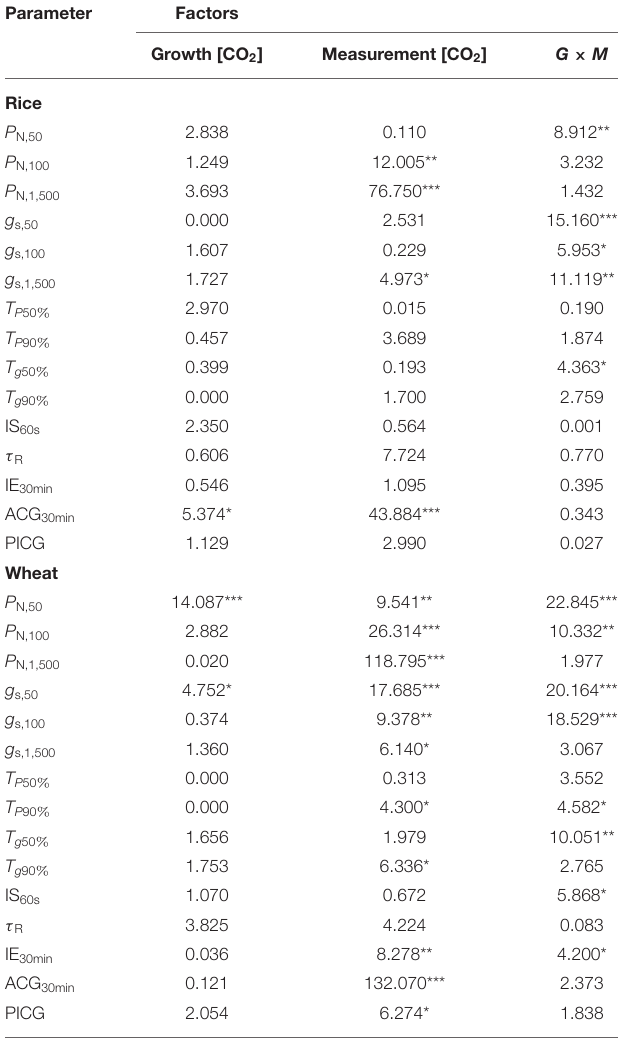
TABLE 3 | The influences of growth ( G ) and measurement CO 2 concentration ( M ) on the differences in the photosynthetic characteristics of rice and